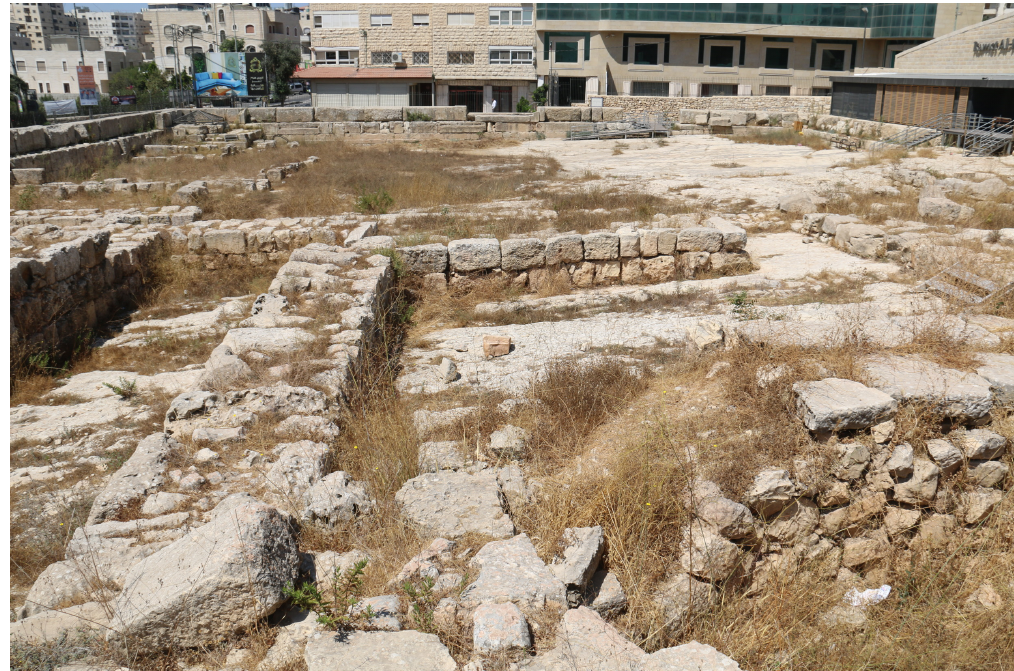
Figure 5 View from the east. In the foreground, the fundaments of the apse and the adjoining rooms of the fourth-century Constantinian Basilica; in the upper left corner, the well and in front of it the area where the tree was located. At the back right, outside of the antique enclosure, the “Centre of Encounter”, built in 2015 but never put into operation (photo: Katharina Heyden,